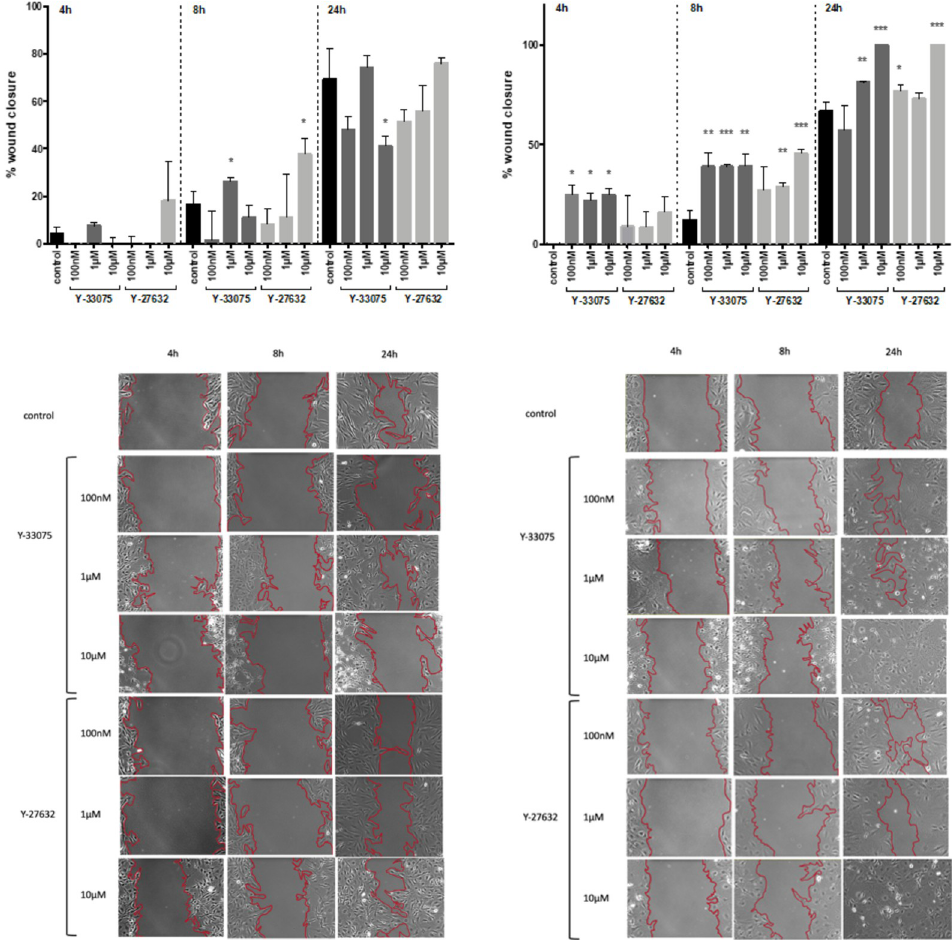
Fig 3. Y-27632 and Y-33075 treatments increase migration in human TWNT-4 and primary murine HSCs. (A) Effect of ROCK inhibitors Y-27632 and Y-33075 on wound closure in activated human TWNT-4 cells measured at 4, 8 and 24 hours (n = 3). (B) Representative images of the wound healing assay in TWNT-4 cells at 4, 8 and 24 hours after treatment with the ROCK inhibitors. The scale bars apply for all images and the length represents 200 μ m. (C) Effect of ROCK inhibitors Y-27632 and Y-33075 on wound closure in primary culture-activated FVB/NJ cells measured at 4, 8 and 24 hours (n = 3). (D) Representative images of the wound healing assay taken 4, 8 and 24 hours after treatment of FVB/NJ cells with ROCK inhibitors (scale bars, 200 μ m). Results are expressed as the mean ± standard error of the mean (SEM); � p < 0.05, �� p < 0.01 and ��� p < 0.001.